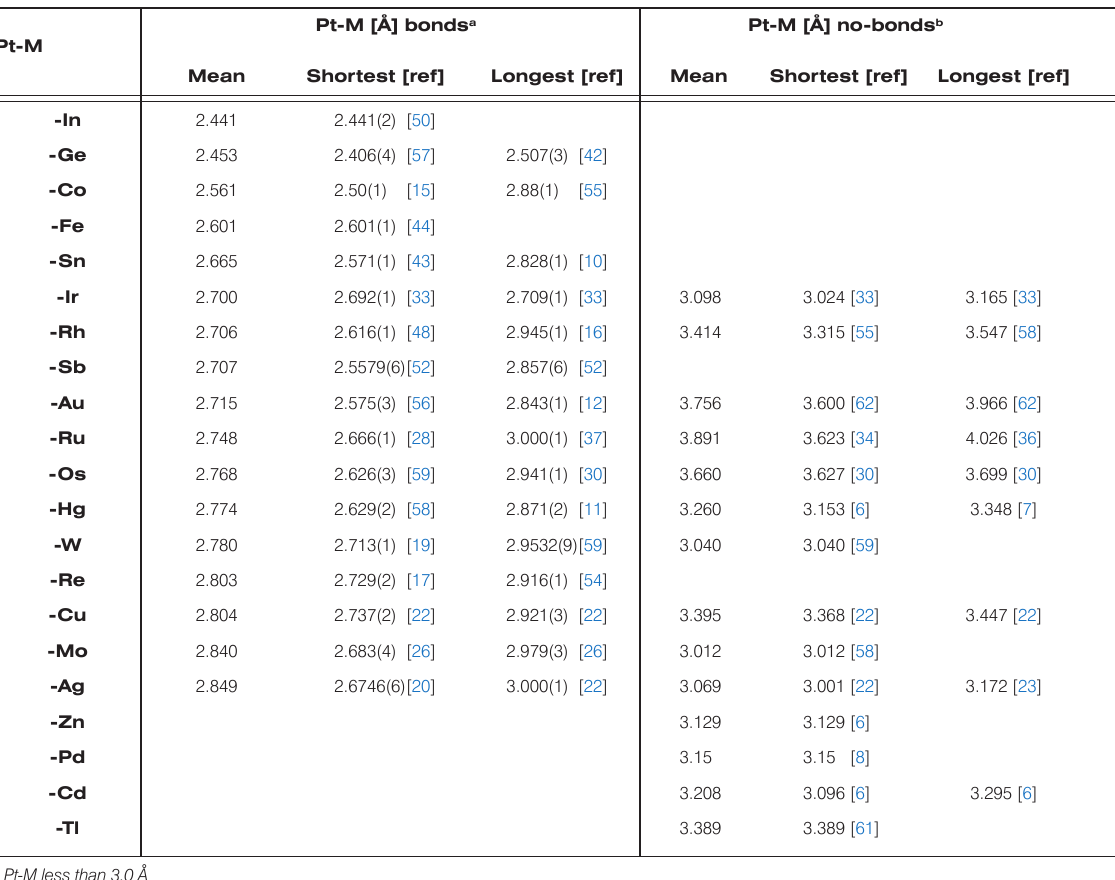
W(µ-Ph PC H )Fe(C H PPh )} PtCl ] [63]. 5 2 5 4 5 4 2 2 2 Pt-M [Å] bonds